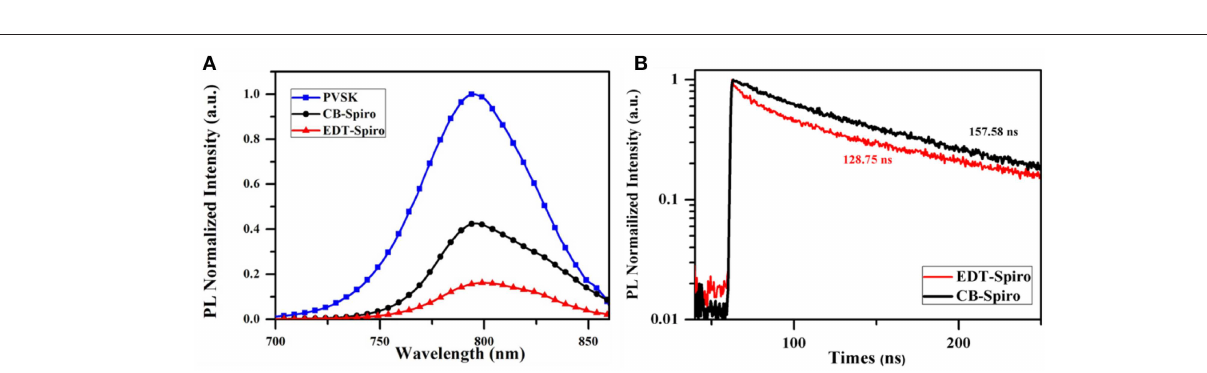
Frontiers in Materials |